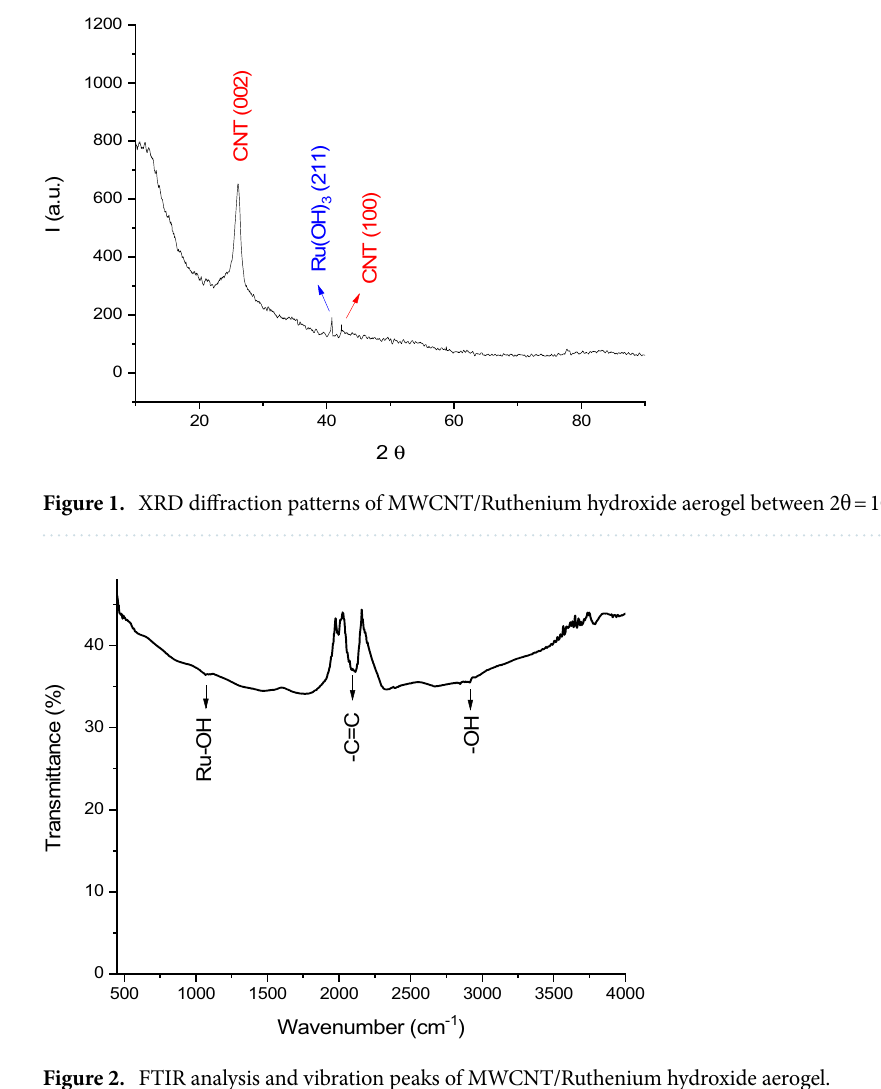
Figure 2. FTIR analysis and vibration peaks of MWCNT/Ruthenium hydroxide